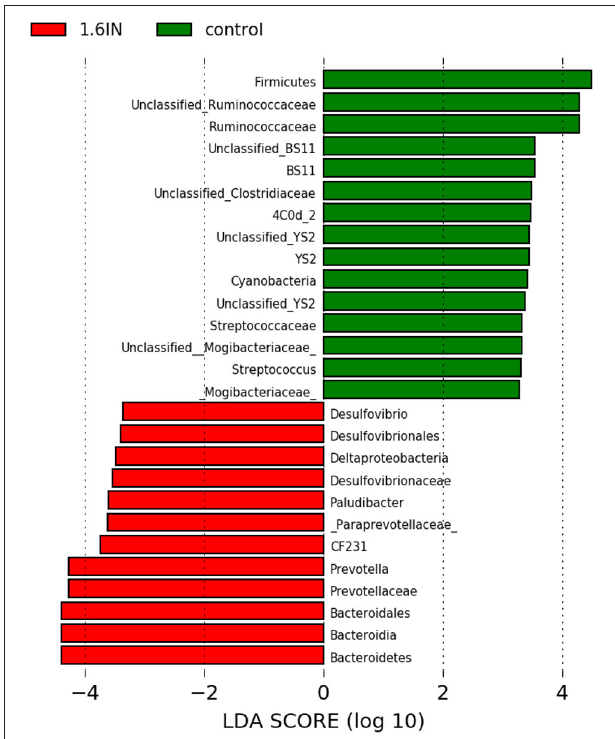
FIGURE 8 | LefSE analysis of colonic microbiota between two dietary groups. LDA scores are calculated for characteristics at the OTU level, and if the value for the LDA score is > 3, it means there is a significant difference.